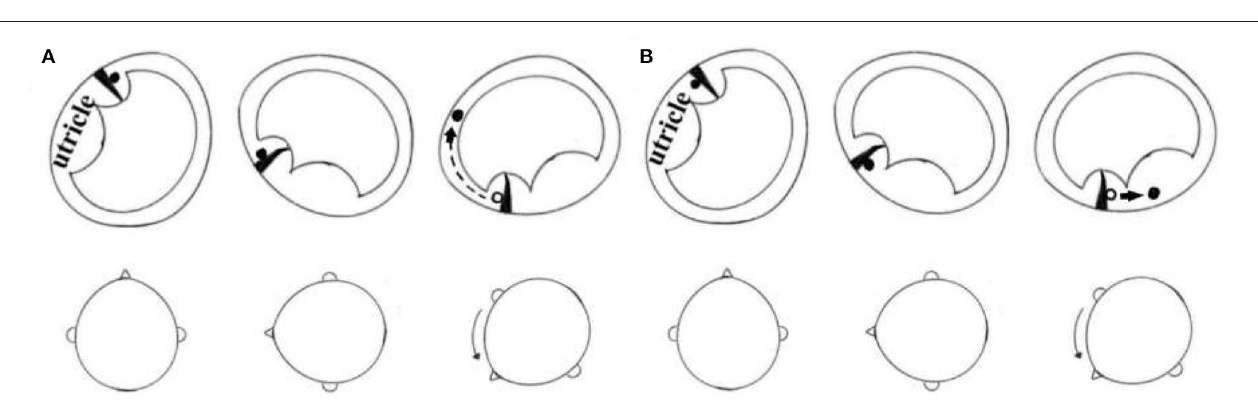
direction. Then, he was treated with the Gufoni maneuver (Gufoni nose-down variation), and the nystagmus